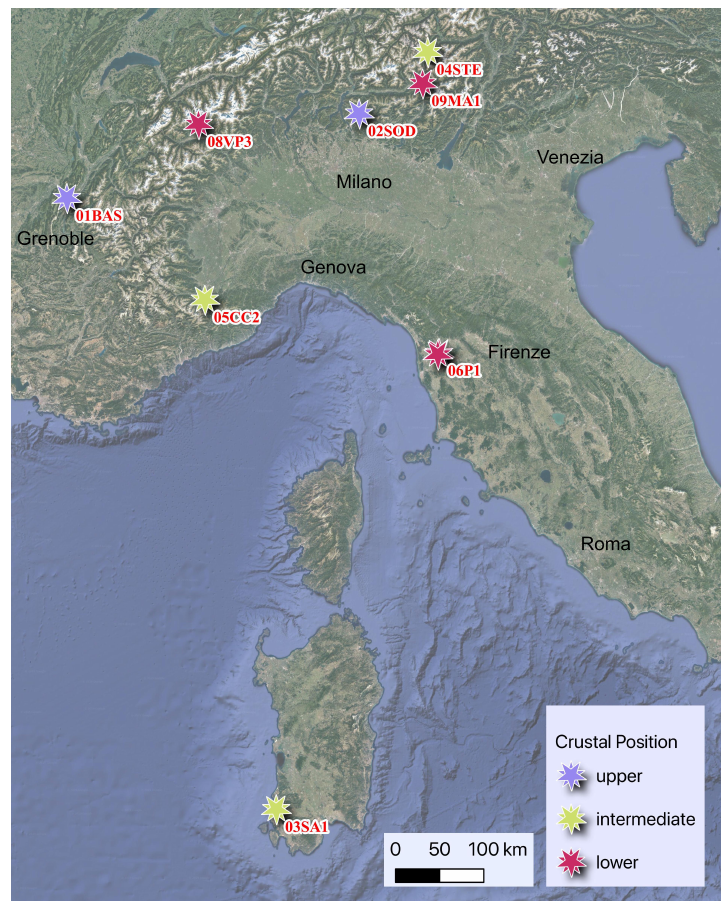
Figure 1. Location and crustal position of the studied samples, see text for